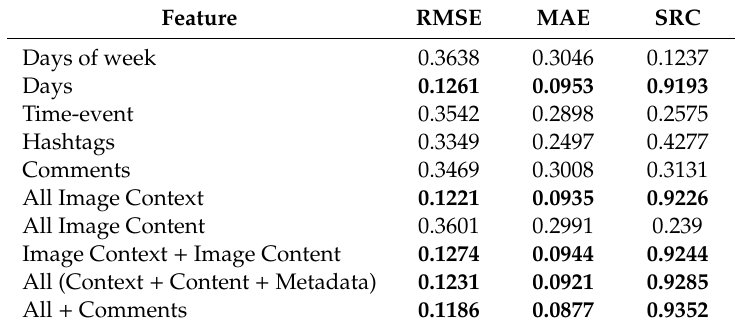
Table 5. Comparison of Likes Prediction using XGBoost tree method with a di ff erent set of